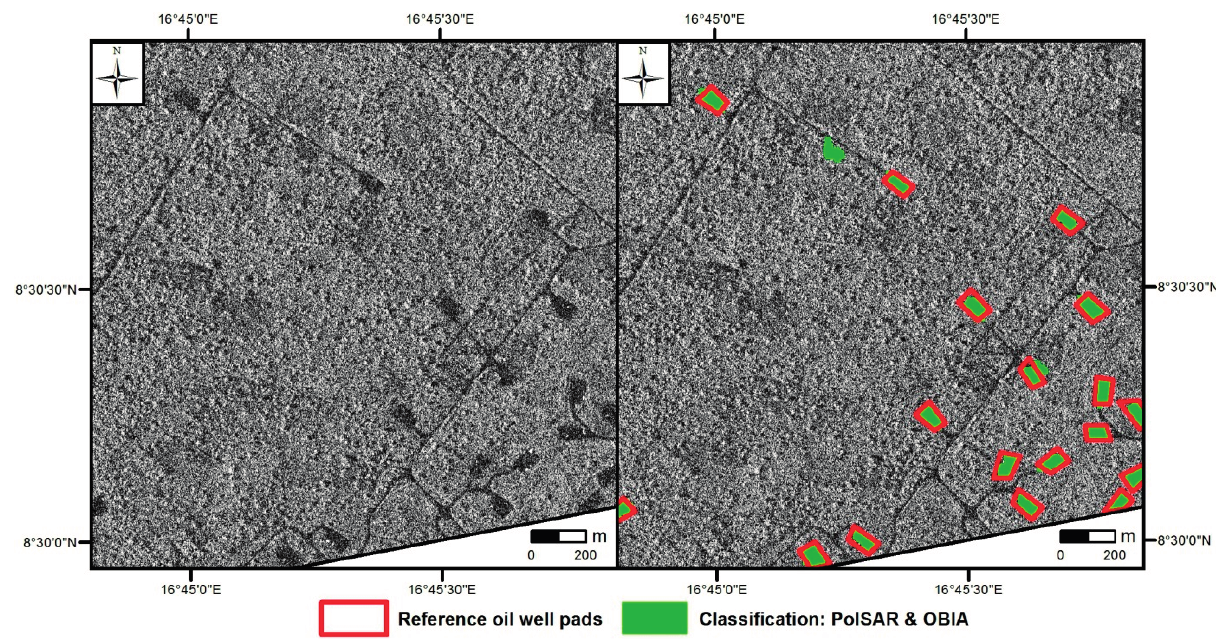
Figure 10. Subset of the study area. Original TerraSAR-X acquisition (5 September 2010) ( left ). Final result of the feature extraction methodology ( right ): Combination of the pixel-based PolSAR Wishart classification (based on H/ α with M = 9; IDAN filter with 50 pixel max. region growing) with the object-based post-classification. The visual comparison of the classification and the reference data confirms the high accuracy values reported in Figure 8. TerraSAR-X © 2014 German Aerospace Center (DLR), 2014 Airbus Defence and Space/Infoterra